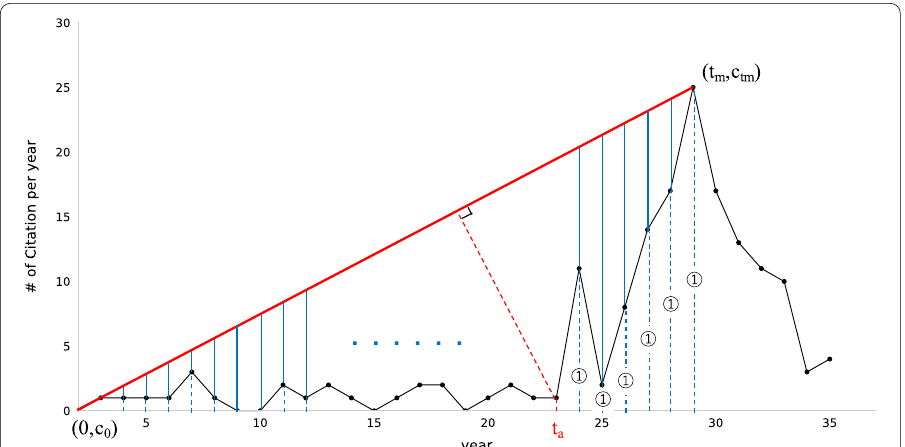
Fig. 3 Illustration of the definition of the beauty coefficient B and its awakening year t a . The black curve represents the number of citations c t received by the paper at age t . The awakening time t a ≤ t m is defined as the age that maximises the distance from the line connceting points ( 0, c 0 ) and ( t m , c t m ). B is calculated as a summation of the ratio of blue lines against each blue dot line from 0 to t